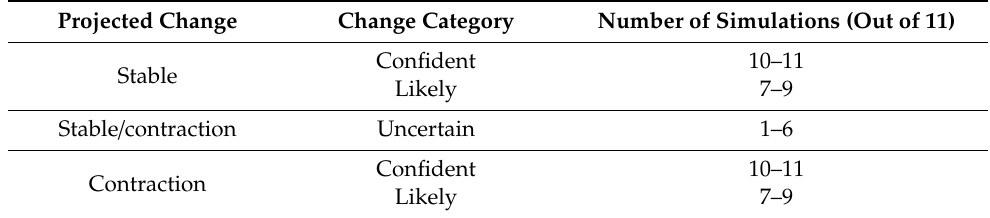
Table 2. Categories of projected change of the alpine tundra domain (ATD) to the di ff erent scenarios and warming levels. Note that the category expansion was not included because none of the simulations project expansion of the